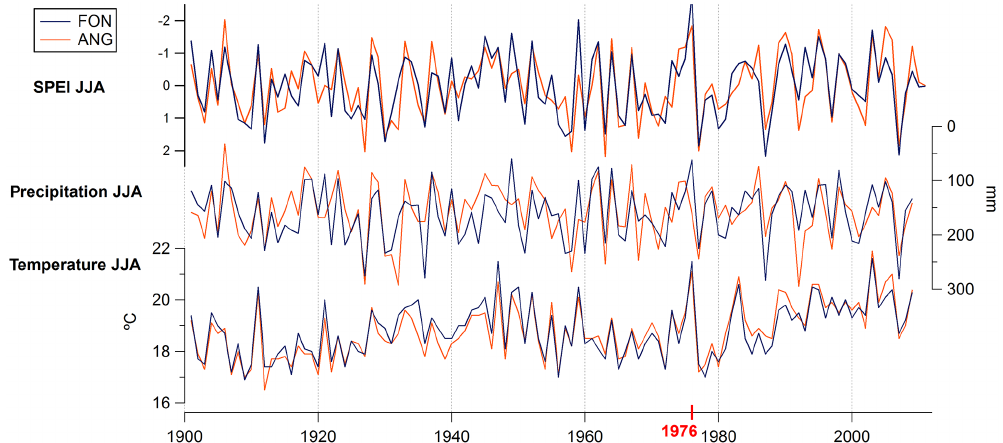
Figure 2. Time series of the drought index SPEI (negative values indicate dry conditions), precipitation and temperature, June–August (JJA) averages for Fontainebleau (FON) and Angoulême (ANG). Note that the axes for SPEI and precipitation are reversed, so that upward values reflect warm and dry years. The year of the exceptional drought 1976 is marked in red. See text for data